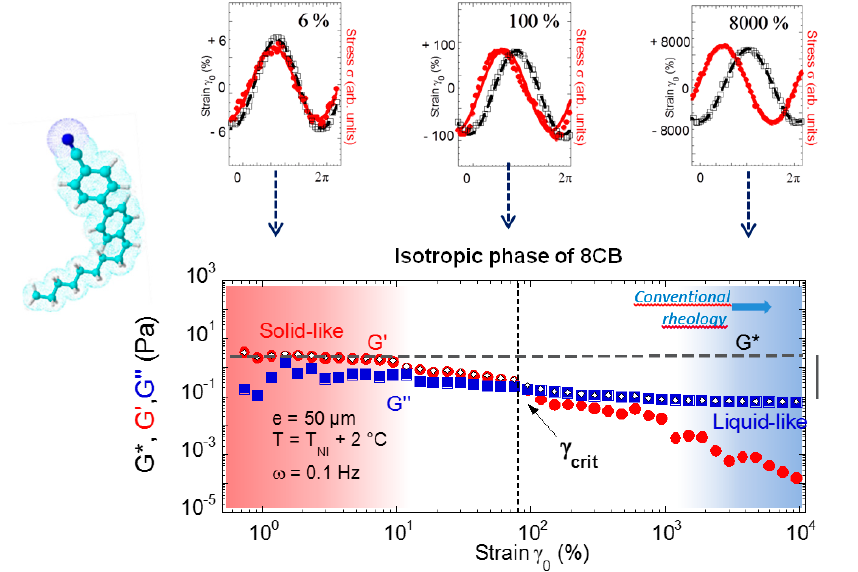
Figure 10. Mechanical response of 4-octyl-4 ′ -cyanobiphenyl (8CB) in the isotropic phase at a 0.050-mm gap thickness (reproduced with permission from reference [50]). Upper figure: The elastic response is evidenced by in-phase behavior of strain and stress waves. At larger strain amplitudes, the strain (black line) and stress (red line) waves become progressively π /2 phase-shifted, indicating a liquid-like behavior characterized by the tabulated viscosity of 14 mPa.s. Bottom figure: Strain dependence (logarithmic scales) of the viscoelastic moduli (G’(•), G”( ■ )): ( a ) At low strain amplitude (typically γ 0 = 6%), the isotropic liquid exhibits an elastic response with G’ > G’’ and G’, G’’ nearly constant. The grey dotted line indicates the reference value of the stress modulus in nearly equilibrium conditions and the grey vertical bar indicates the modulus loss with respect to the elastic regime.